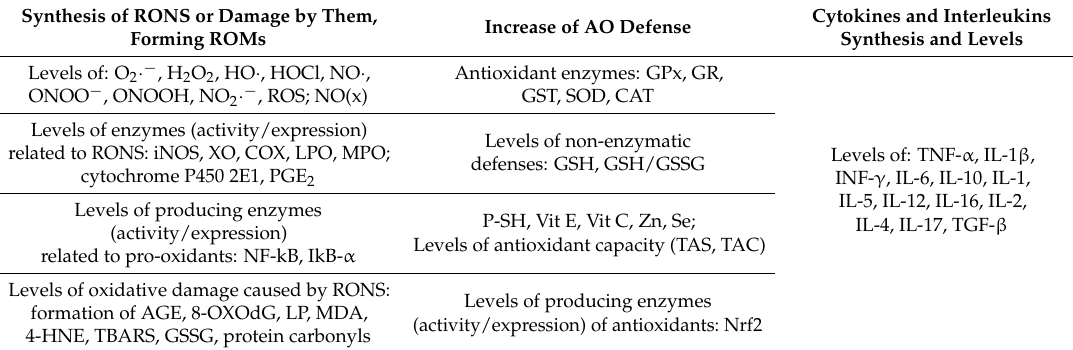
Increase of AO Defense